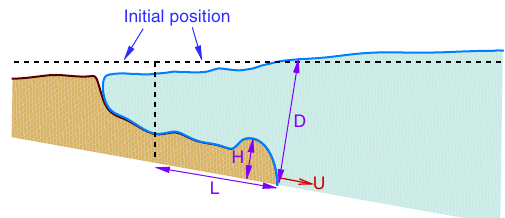
Figure 13. Run-out and head